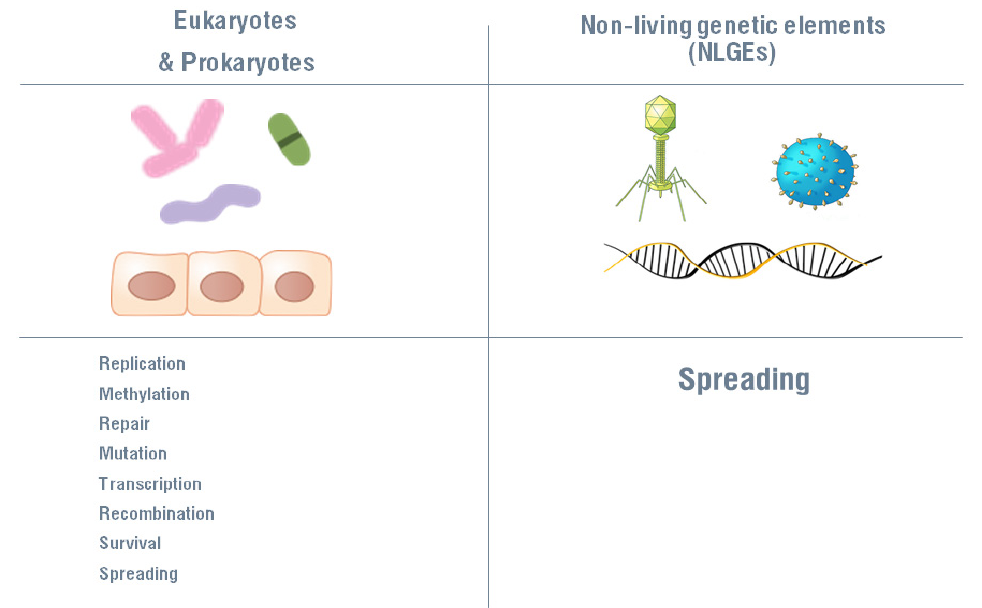
Figure 1: Living organisms are distinguished from non-living objects by their role and participation in genetic information